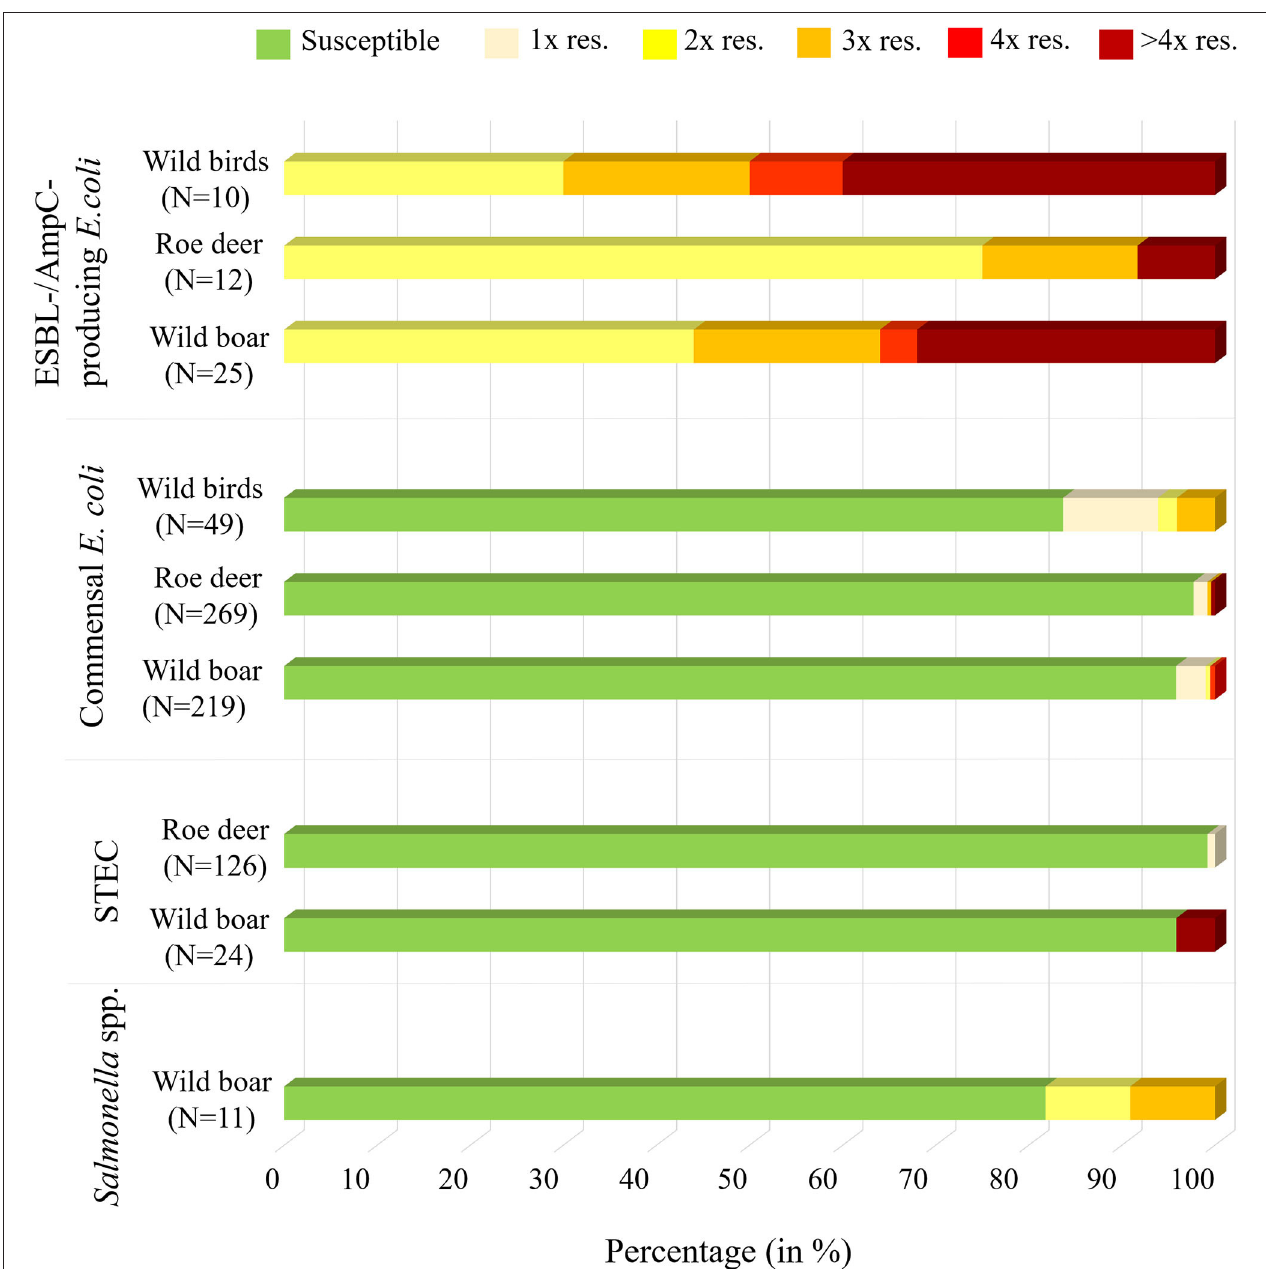
FIGURE 1 | Overview of the isolates found in wild boar, roe deer (excluding Campylobacter spp.) and wild ducks and geese, including information on the percentage of samples that were susceptible to al testes substances or resistant to one (1x res.), two (2x res.), three (3x res.), four (4x res.) or more than four classes ( > 4x res.) of antibiotic